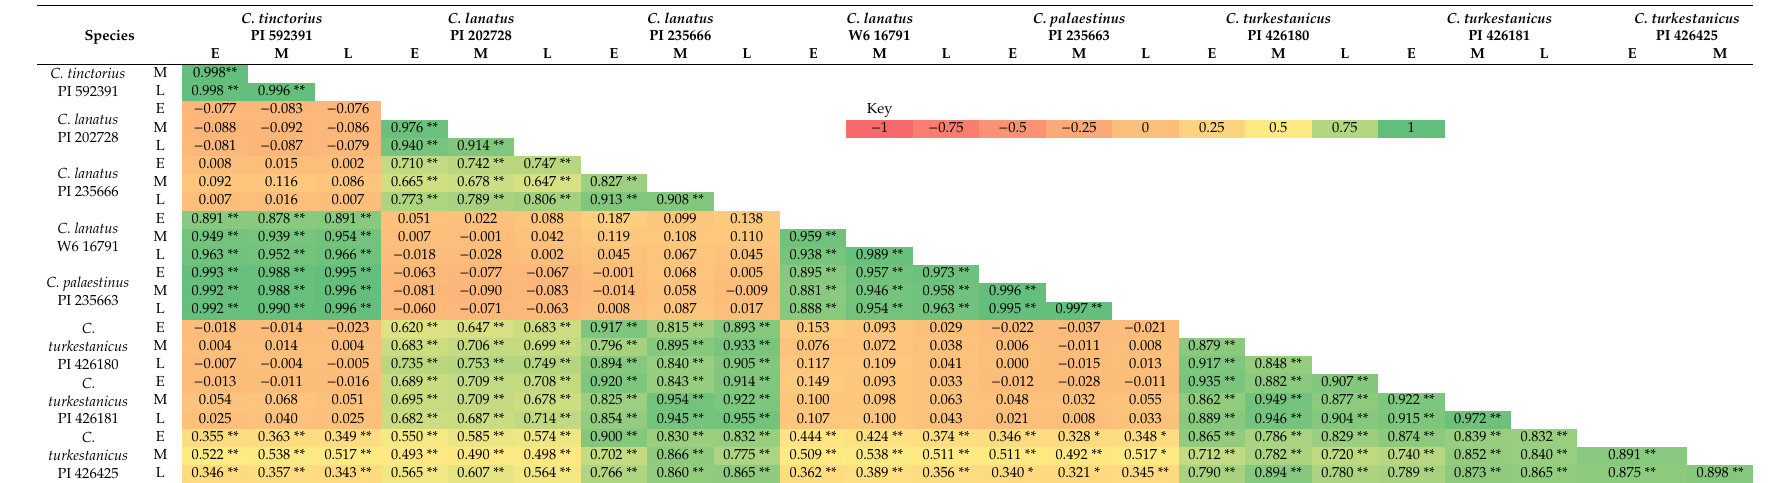
Table 1. Pearson correlation coe ffi cients among sa ffl ower wild species at di ff erent developmental stages based on metabolite levels.